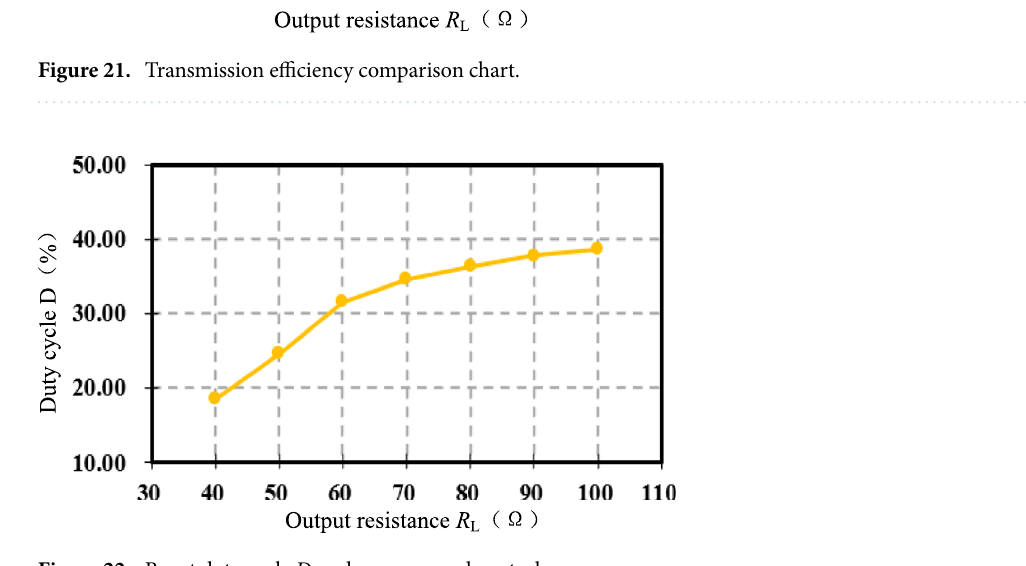
Figure 22. Boost duty cycle D under compound